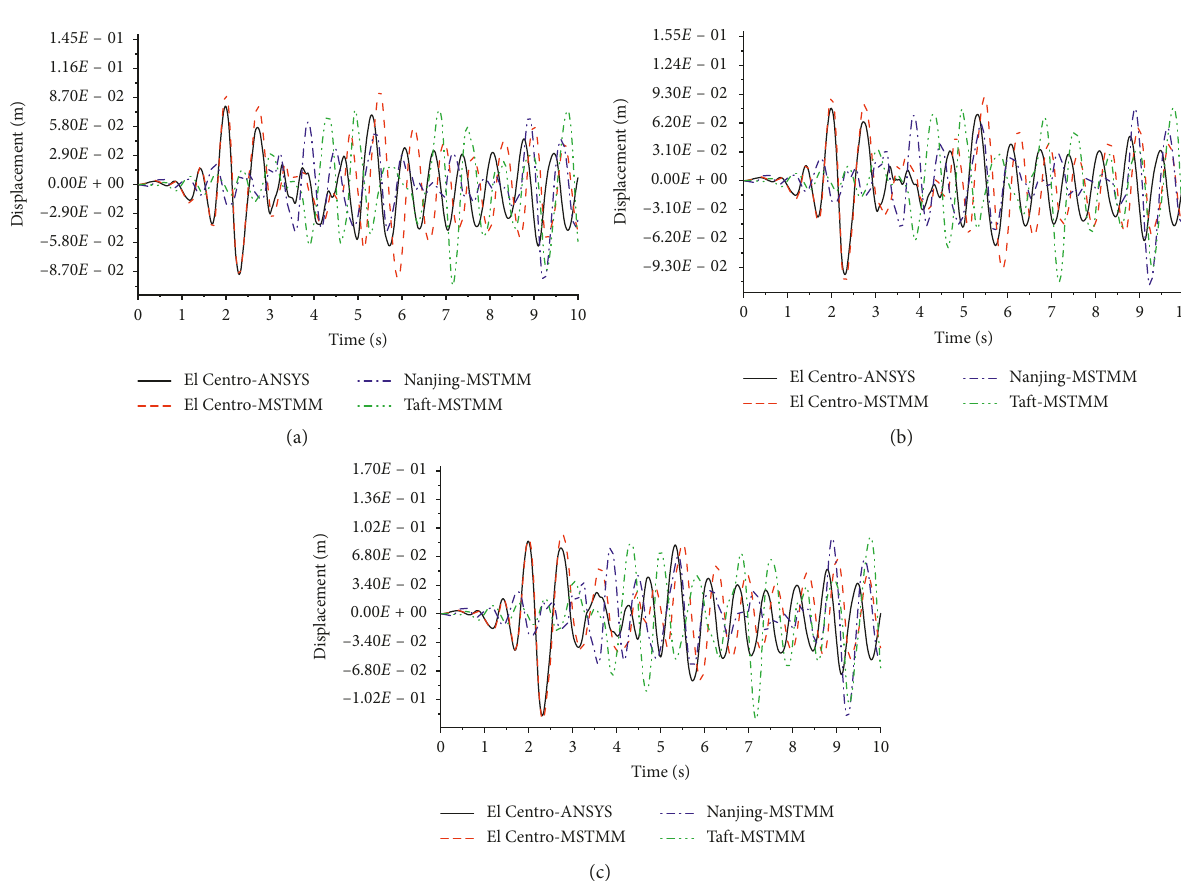
Figure 17: Time-history diagram of J (c)